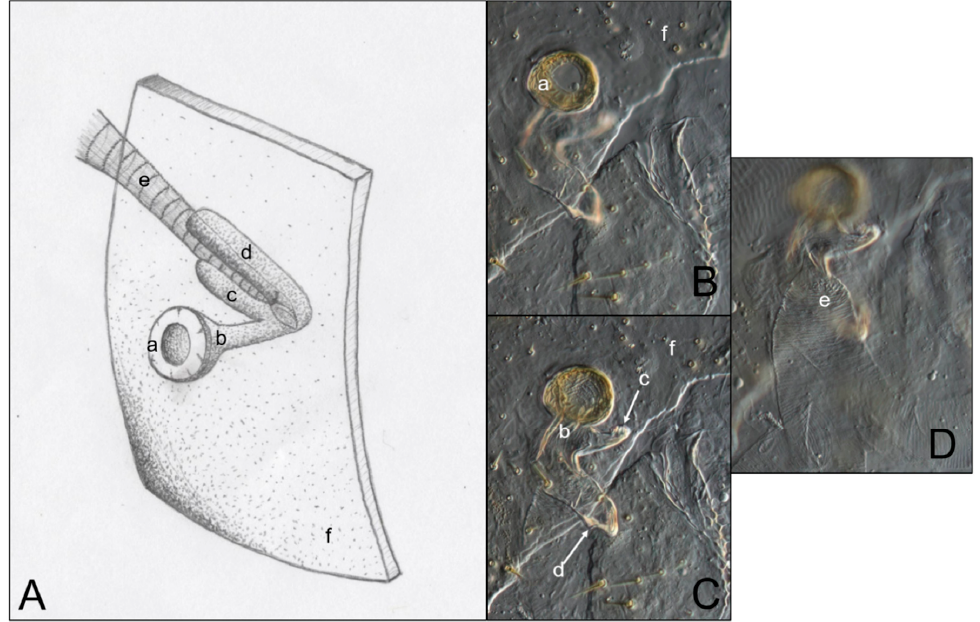
Figure 6. Comparison of an artist’s interpretation and photographs of the attachment of the spiracle structure and the trachea in three kalotermitid species ( C. brevis , C. cavifrons , and N. jouteli ). ( A ) Drawing of spiracle-tracheal attachment; ( B – D ) Photograph illustrating spiracular-tracheal attachment at different focal levels. a : spiracle cap (peritreme); b : atrium; c : atrial arm of spiracle structure; d : additional atrial arm of spiracle structure; e : tracheal trunk; f : cuticle.